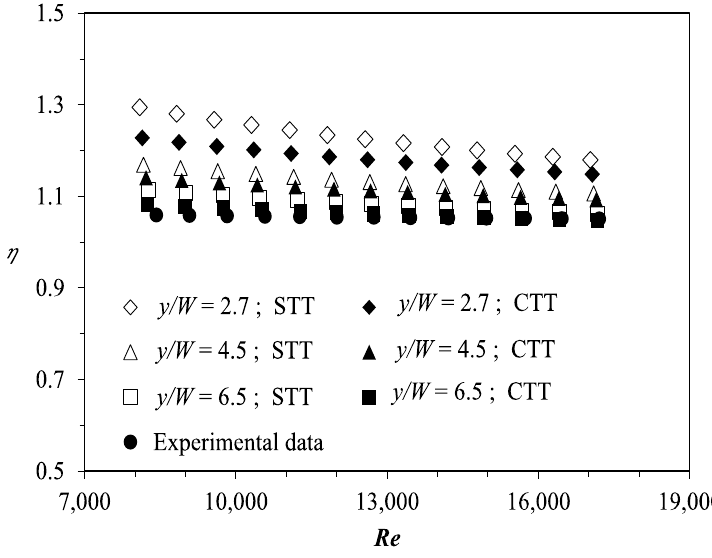
Figure 9. Thermal performance for various CTTs and STTs.